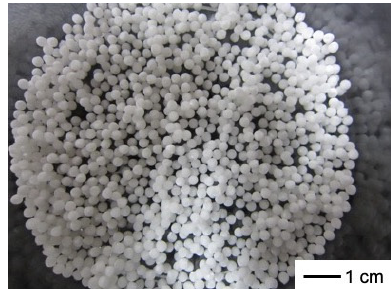
Figure 2. Appearance of chitosan − siloxane hybrid spheres (ChG05, − 20 °C).